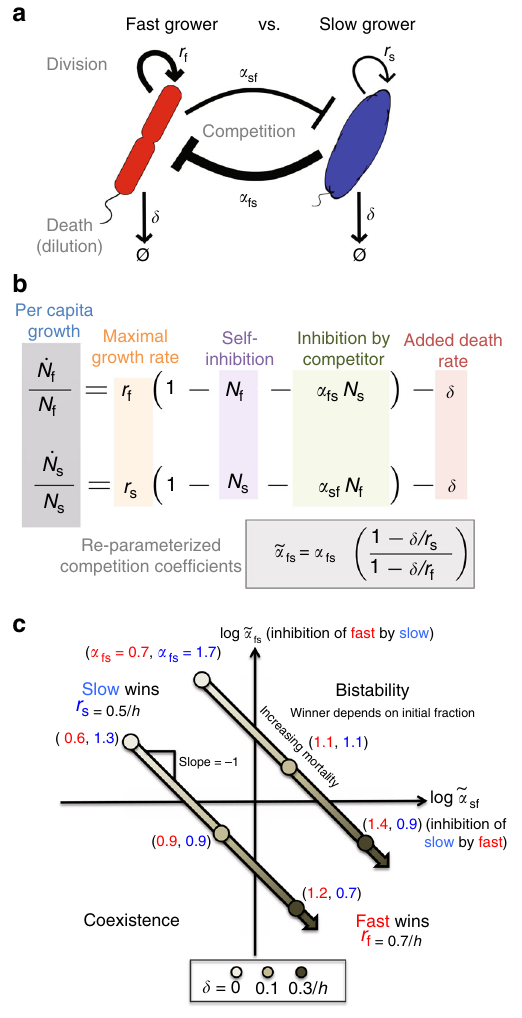
Fig. 2 An increasing global mortality rate is predicted to favor the fast grower. a , b Here we illustrate the parameters of the Lotka – Volterra (LV) interspeci fi c competition model with added mortality: population density N ,